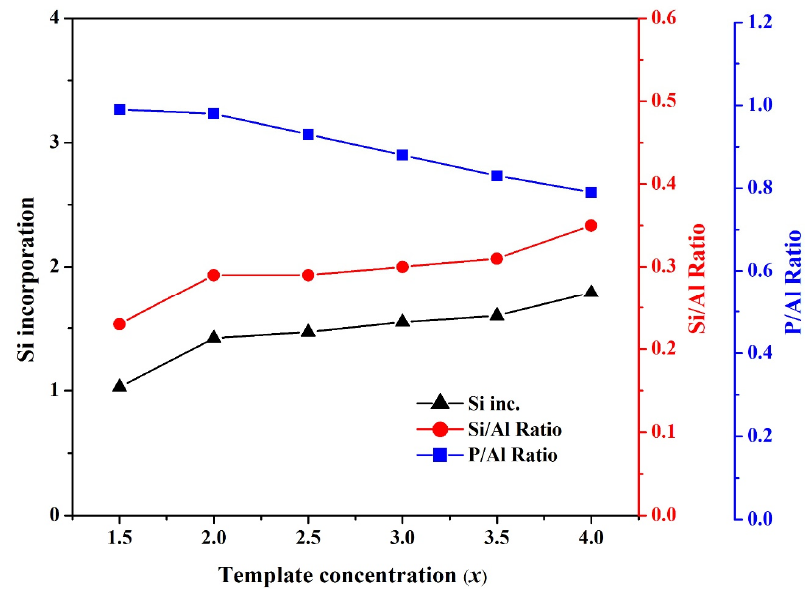
Figure 3. The effect of template concentration ( x ) on the Si/Al ratio, P/Al ratio, and Si incorporation for the synthesized SAPO-34 particles.